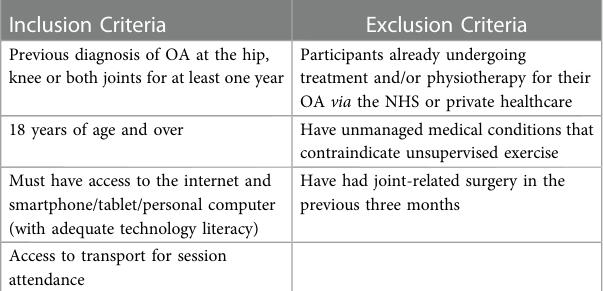
TABLE 1 Study inclusion and exclusion criteria.